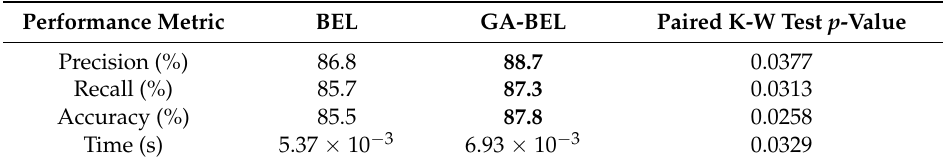
Table 3. Experimental results of BEL vs. GA-BEL on the Heart